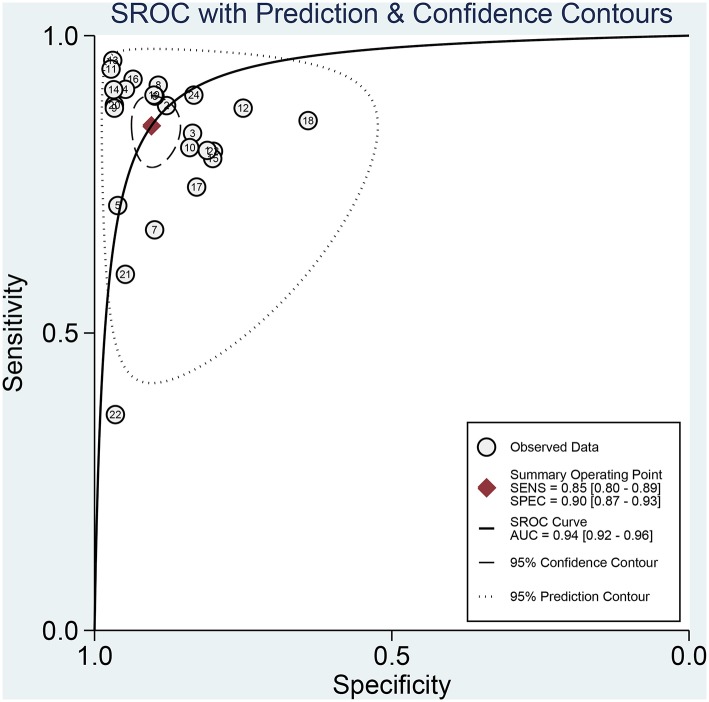
The SROC curve of serum Zta antibody for NPC.